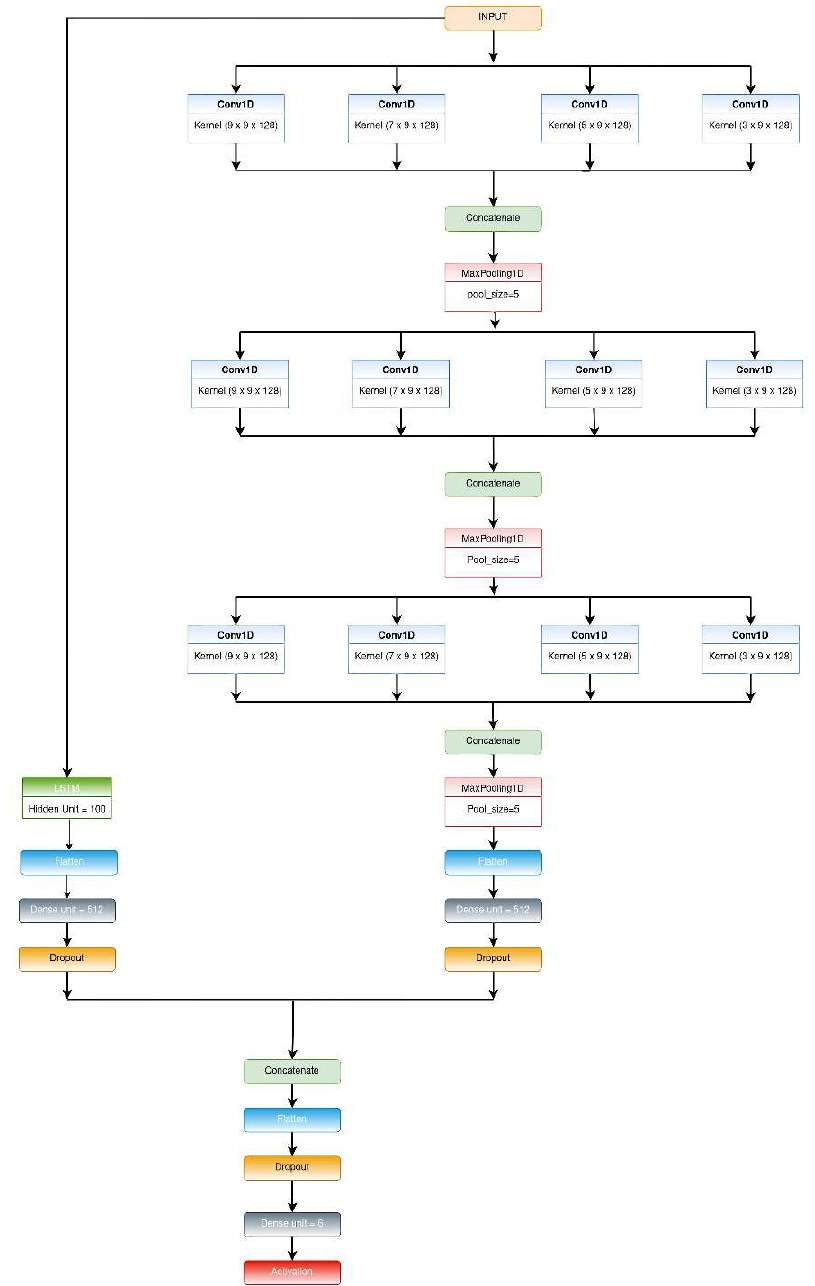
Figure 3. Schematic diagram of the CNN-LSTM-net model.